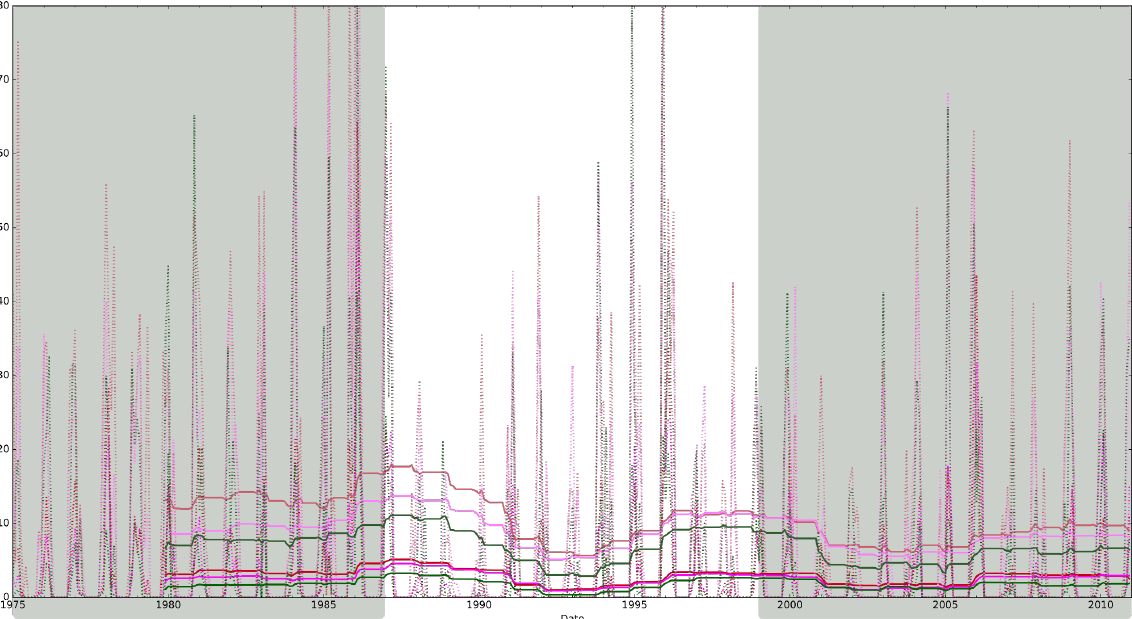
Figure 9. Average values (dotted lines) and their 5-year-running means (solid lines) for the fresh snow (pale colors) and the snow height for the Aichfeld subregion (red), the Murdurchbruchstal subregion (purple) and the Leibnitzer Feld subregion